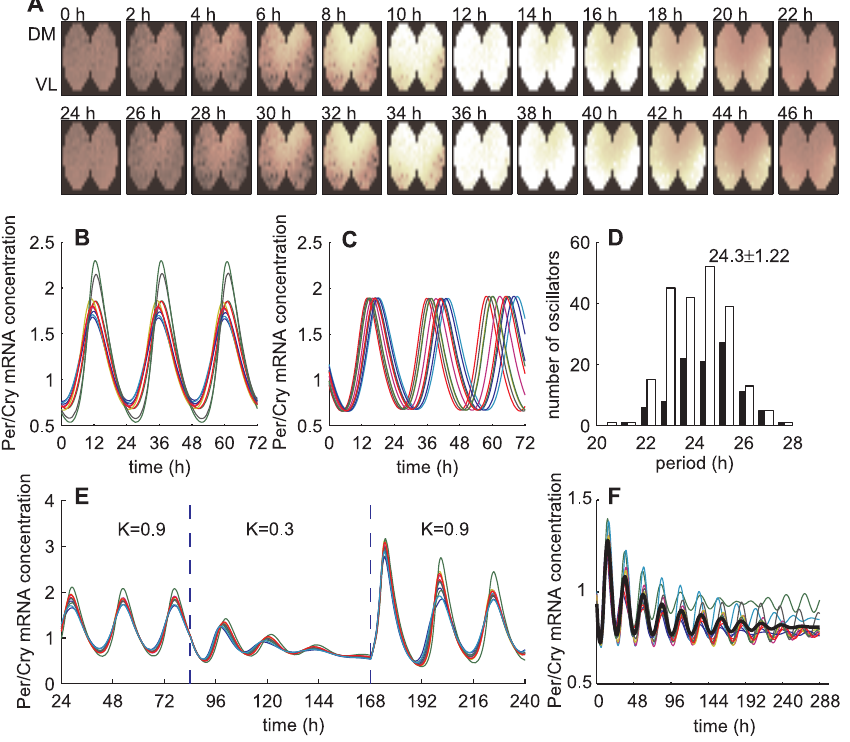
Figure 3. Synchronization of Damped Oscillators (A) Simulated evolution of Per/Cry mRNA expression over 48 h of 309 coupled neurons in a 2-D SCN slice with a type 2 coupling (nearest-neighbor coupling; d max ¼ 3.5, K ¼ 0.9). Dark brown corresponds to a low level of Per/Cry expression, while white corresponds to a high expression. (B) Time series of ten randomly chosen oscillators from the slice shown in (A). (C) Time series of ten randomly chosen uncoupled, free-running ( d max ¼ 0, K ¼ 0.9) oscillators. (D) Distribution of cell-intrinsic periods (black, VL neurons; white, DM neurons; total number of cells, n ¼ 309). (E) Time series of ten transiently weakly coupled oscillators ( d max ¼ 3.5, K ¼ 0.3 between t ¼ 84 and 168 h; n ¼ 309). (F) Evolution of ten randomly picked oscillators simulating loss of VPAC 2 receptor ( f decreasing function of the distance, d max ¼ 1, K ¼ 0.45, n ¼ 309). The decreasing f (see Equation 15) means that the signal is stronger for autocrine coupling. The thick black lines represent the average output. The resulting period is 24.7 h, and the average period of individual oscillators is 24.6 6 1.2 h.